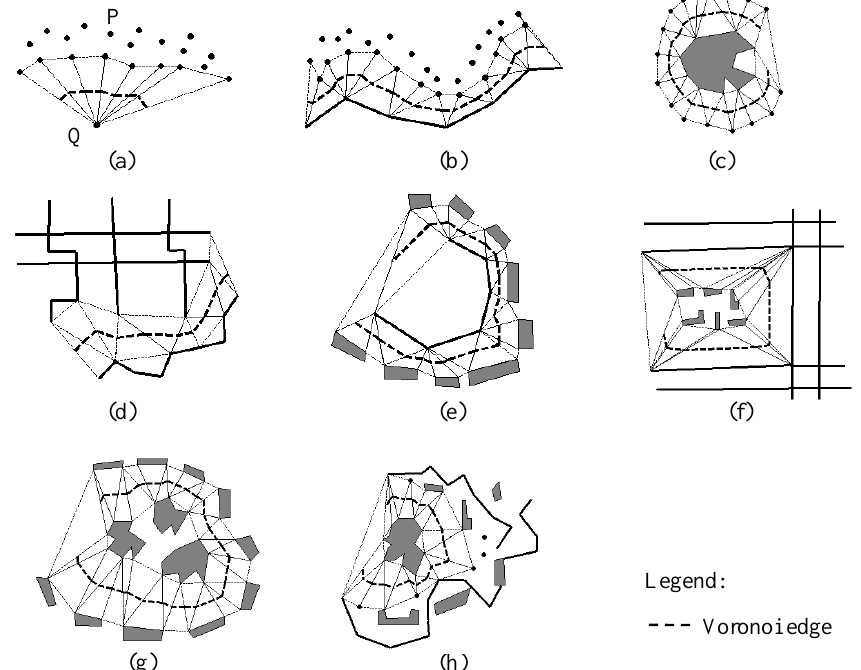
Legend: Voronoi edge